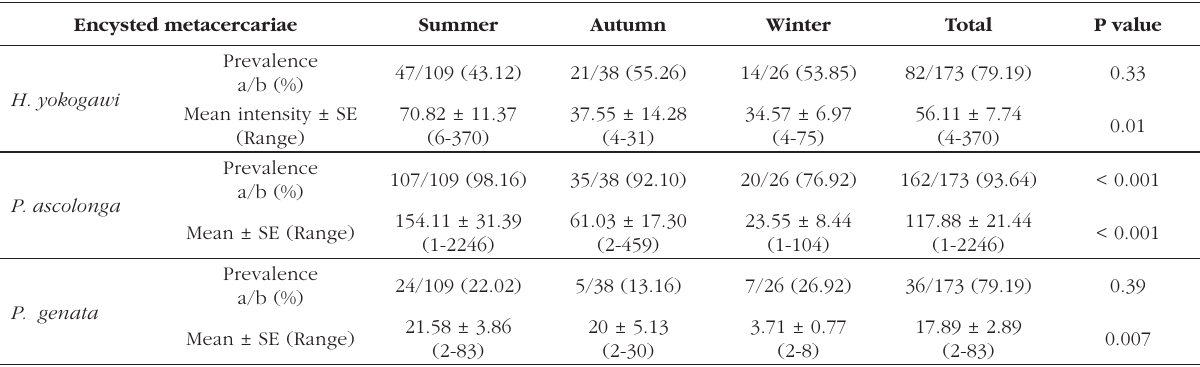
Encysted metacercariae